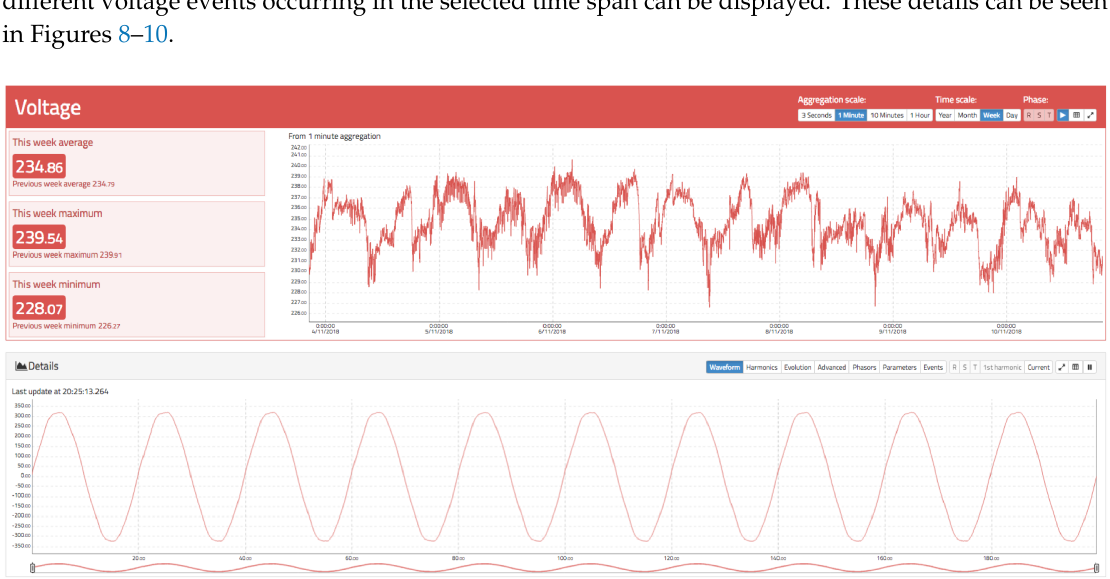
Figure 8. Voltage view of